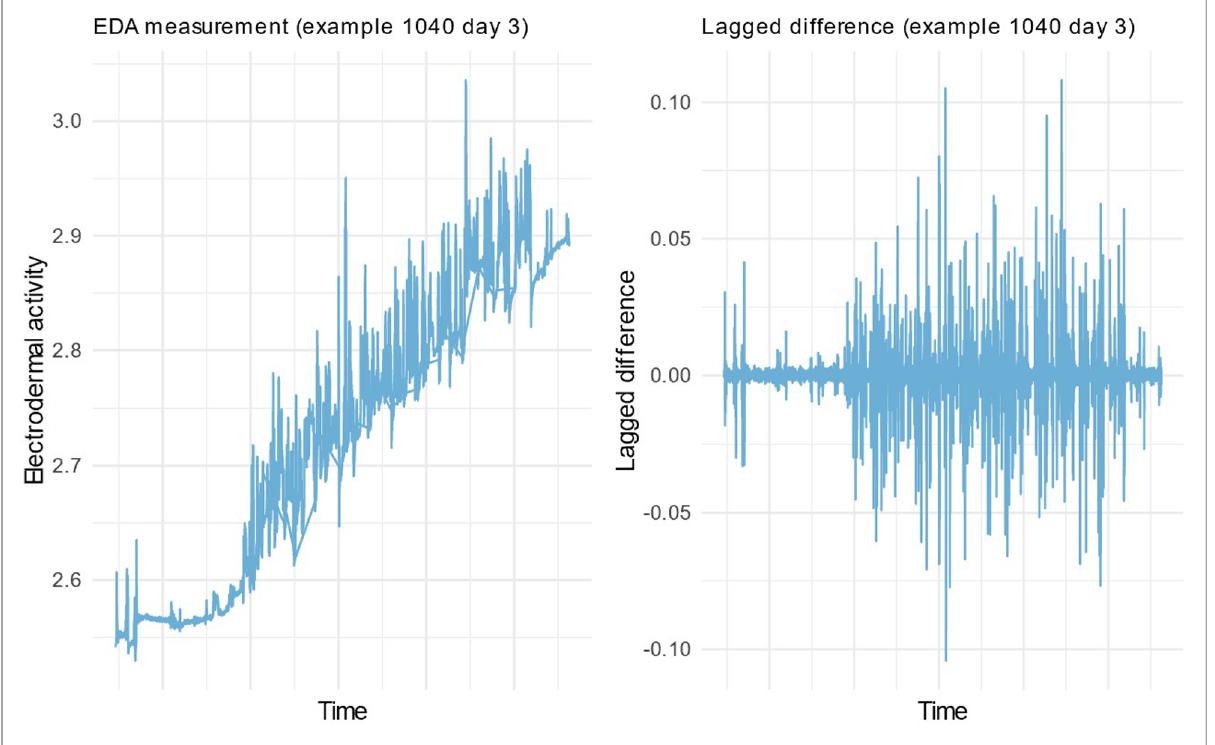
FIGURE 1 Example EDA signal with Tonic and Phasic components (left) and with the Phasic component only